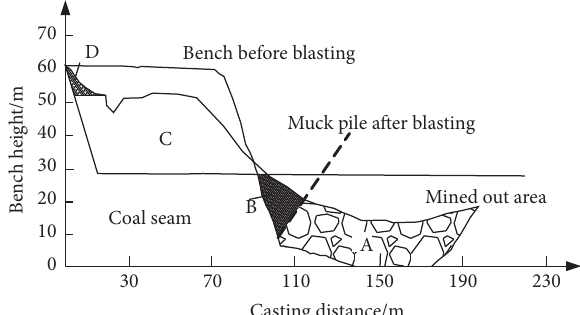
Figure 1: Schematic diagram of effective casting rate calculating